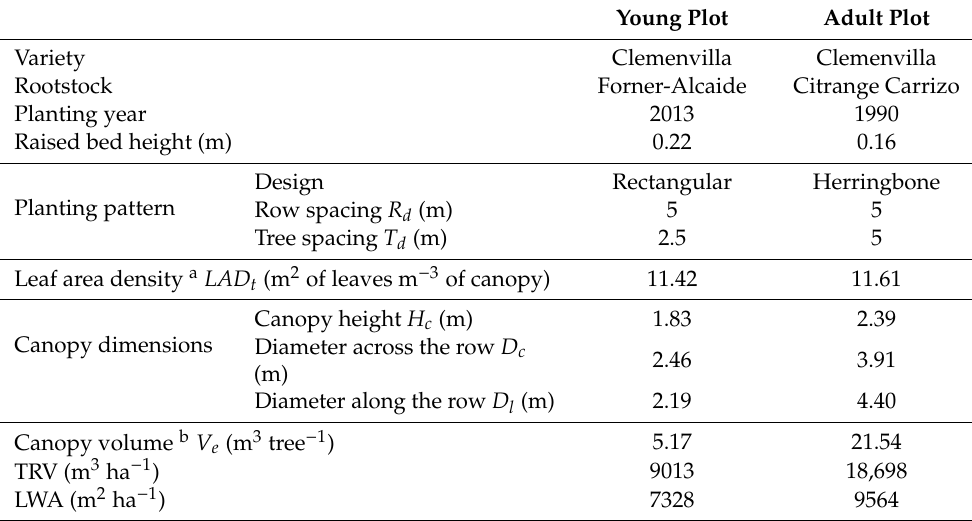
Table 2. Characteristics of the experimental